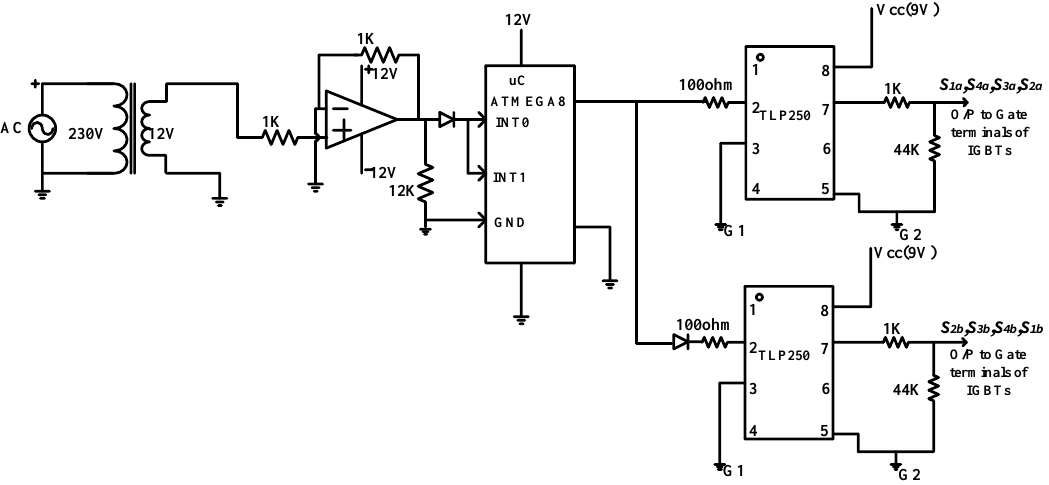
Figure 16. Circuit implementation of proposed controller for SPMC as a resonant converter for IH applications.